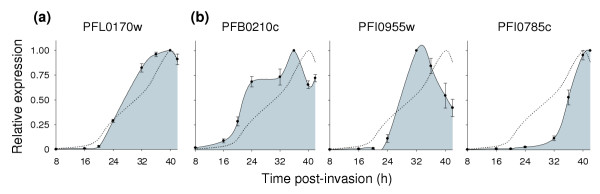
Stage-dependent gene expression of transporters throughout the intraerythrocytic cycle of P. falciparum. (a) A putative transporter of the MFS family; (b) the three P. falciparum members of the sugar porter family (a subfamily of the MFS). The PFB0210c gene encodes the P. falciparum hexose transporter, PfHT1 [46]. RT-PCR was conducted to semi-quantify the level of gene expression in ~1.5 × 104 parasitized cells at each growth stage. Relative expression (y-axis) is the ratio of the density of the band from the PCR product at each time point in the life cycle relative to that at the time point giving the largest yield of PCR product. Ratios calculated from replicate gels from the same PCR were averaged before the data from the two time courses (carried out approximately 4 months apart and each consisting of ≥ 2 PCRs) were combined to give the mean ± S.E. For comparison, the relative amount of total RNA in the parasitized cell over the same growth stages is also presented (dotted line).